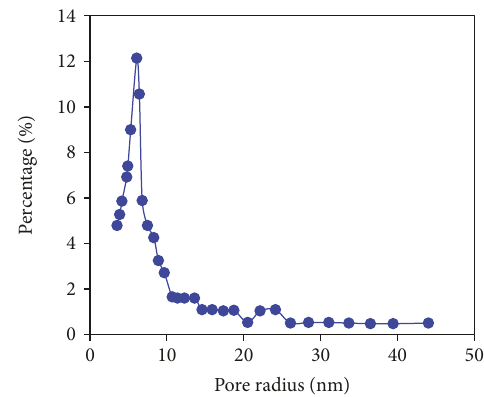
Figure 20: Pore size distribution curves of typical shale in Barnet (from [41]).